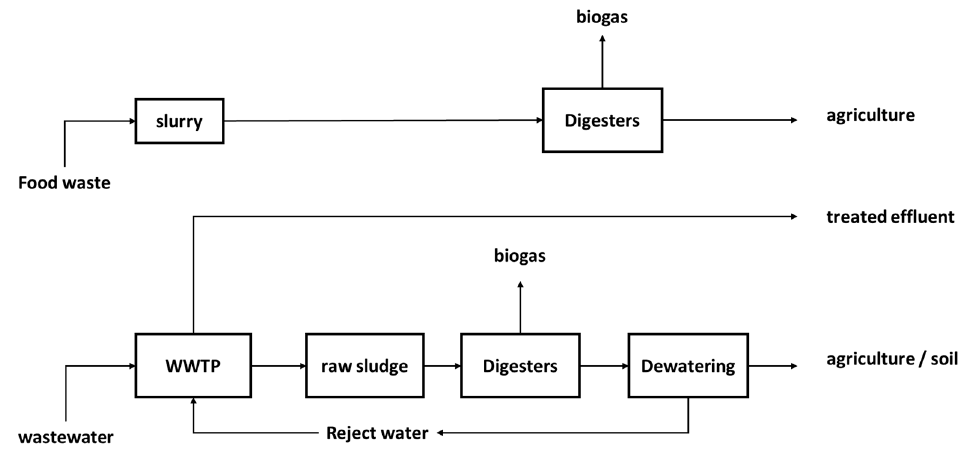
Figure 4. An overview of the processing stages of the base WWTP and food waste treatment facility.